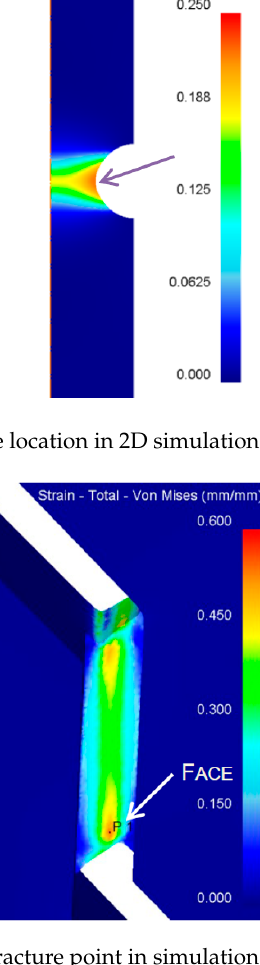
Figure 22. The fracture point in simulation of the shear test.